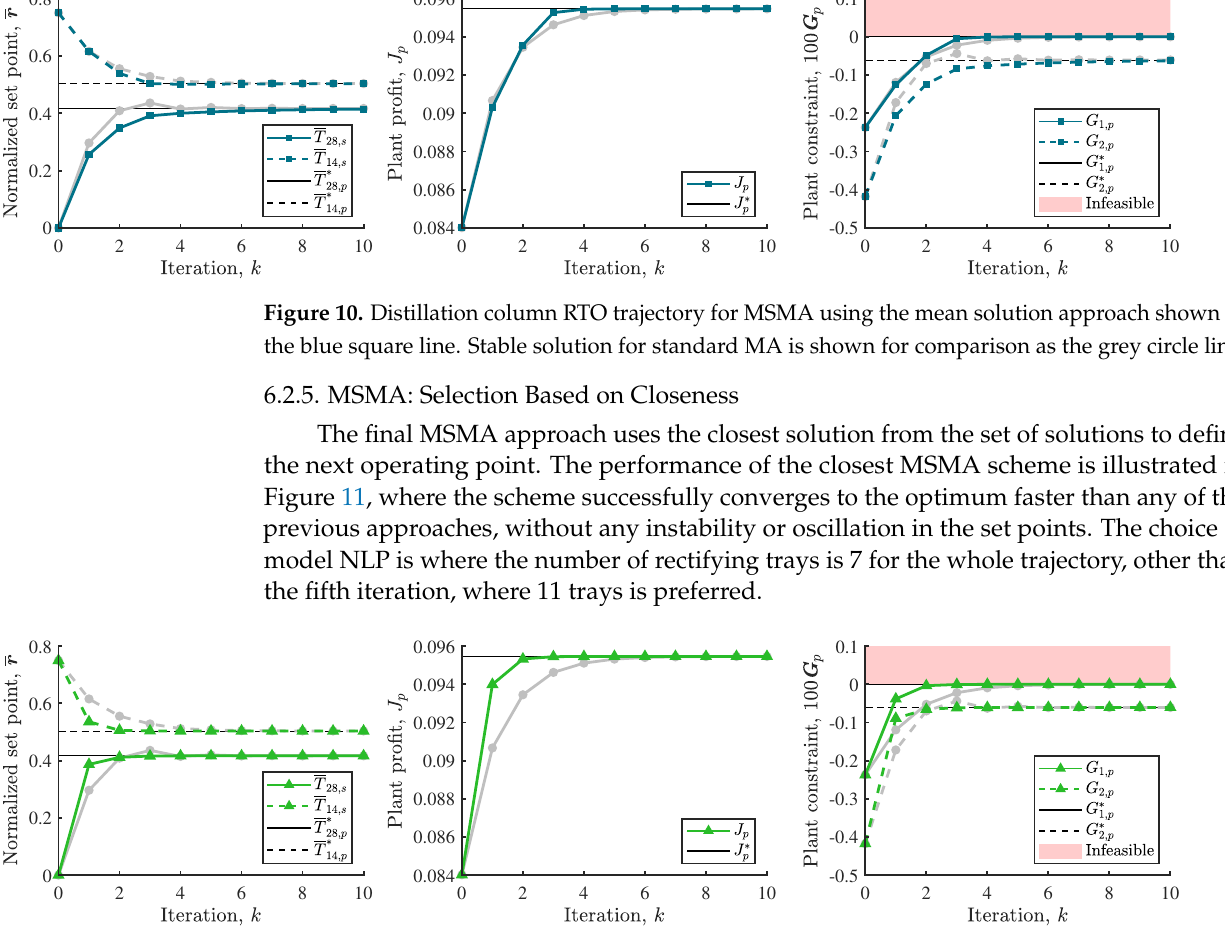
Figure 11. Distillation column RTO trajectory for MSMA using the closest solution approach shown as the green triangle line. Stable solution for standard MA is shown for comparison as the grey circle